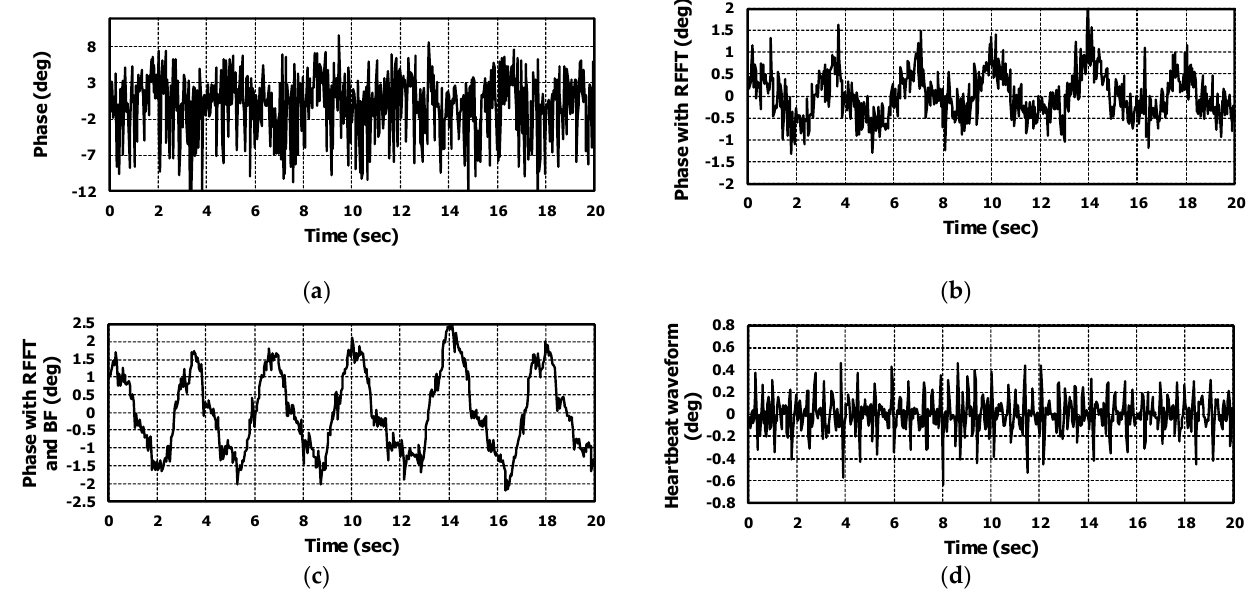
Figure 11. For the case without interferer, the extracted phase signal from measured raw data of radar. ( a ) is the phase signal not applying range-FFT and beamforming, ( b ) is the phase signal applying ranges-FFT, ( c ) is the phase signal applying range-FFT and beamforming, and ( d ) is the extracted heartbeat waveform from the ( c ).